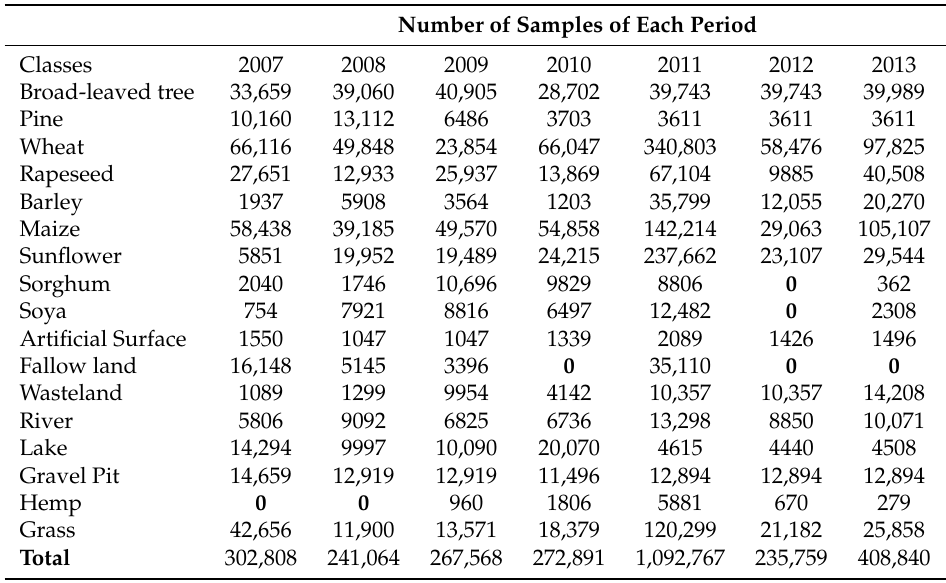
Table 2. Nomenclature and number of samples (pixels) for each period provided by the whole reference data